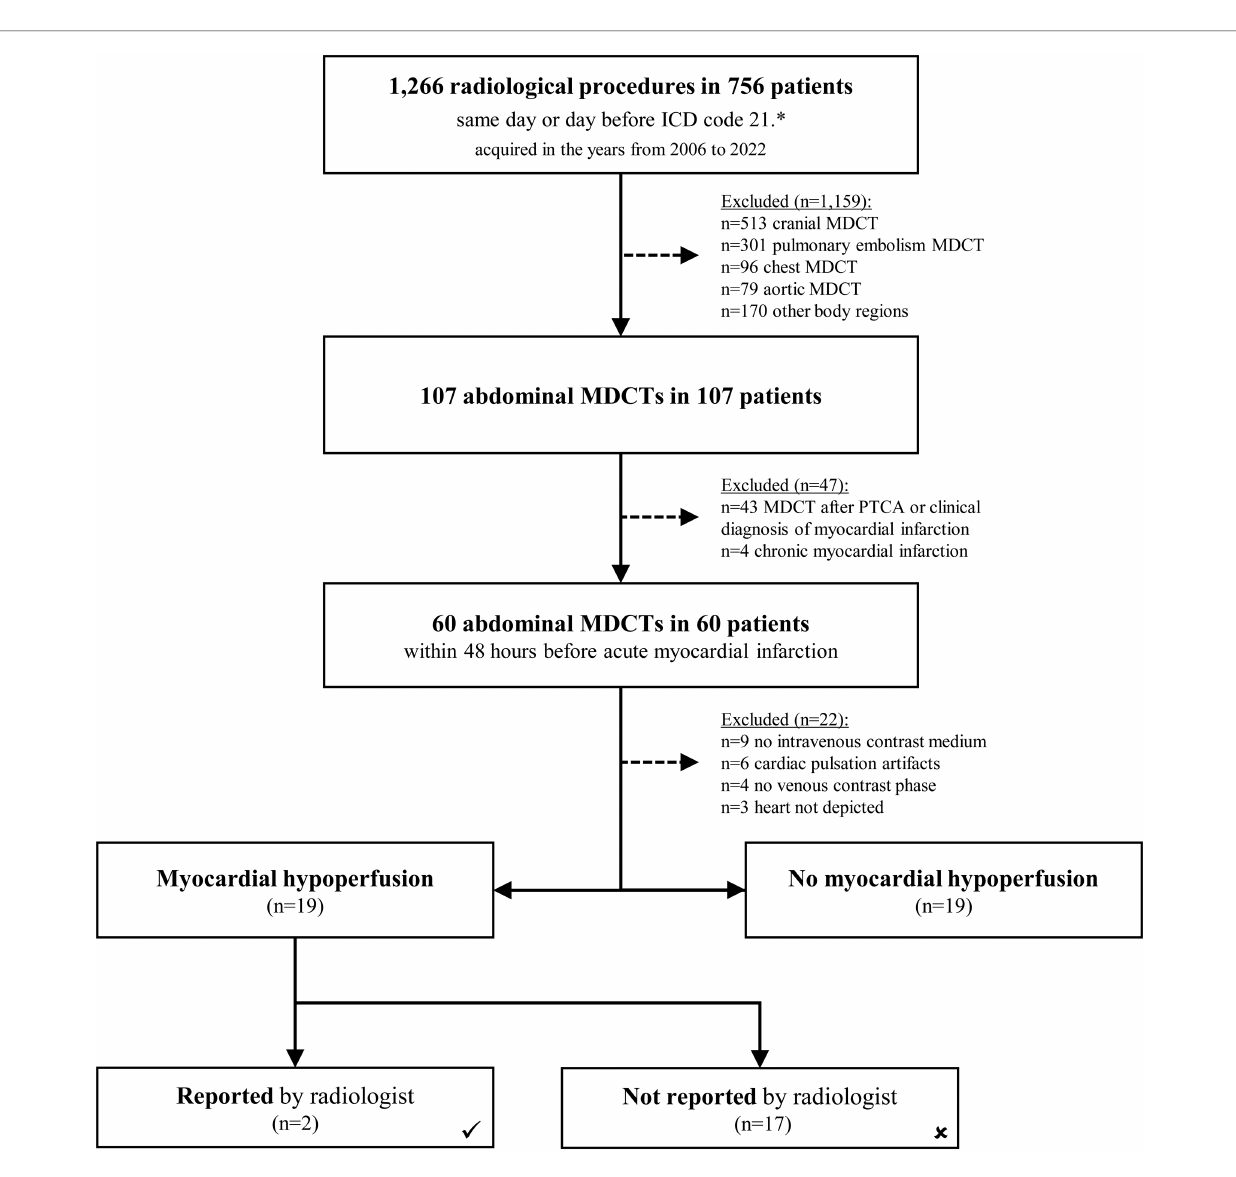
FIGURE 1 Flow-chart of all patients assessed for myocardial hypoperfusion. All eligible MDCT examinations were screened for the presence of myocardial